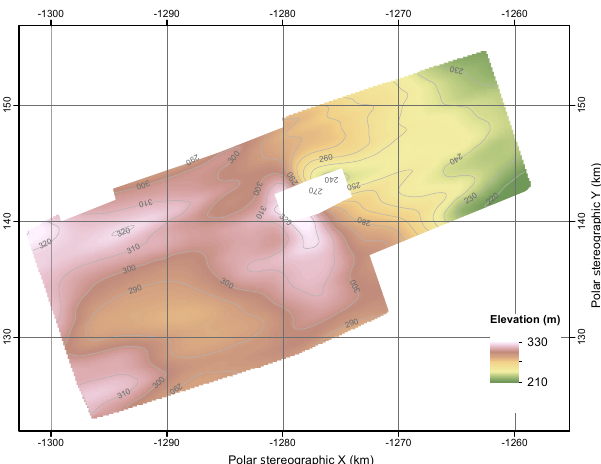
Figure 6. Map of the elevation of the surface of the ice stream ref- erenced to the WGS84 ellipsoid. Data were collected using a dual- frequency GPS unit on the radar receiver sledge and post-processed using a kinematic technique (see text). Steepest surface slope oc- curs above the upstream end of the bedrock outcrop that forms the central high ridge at the